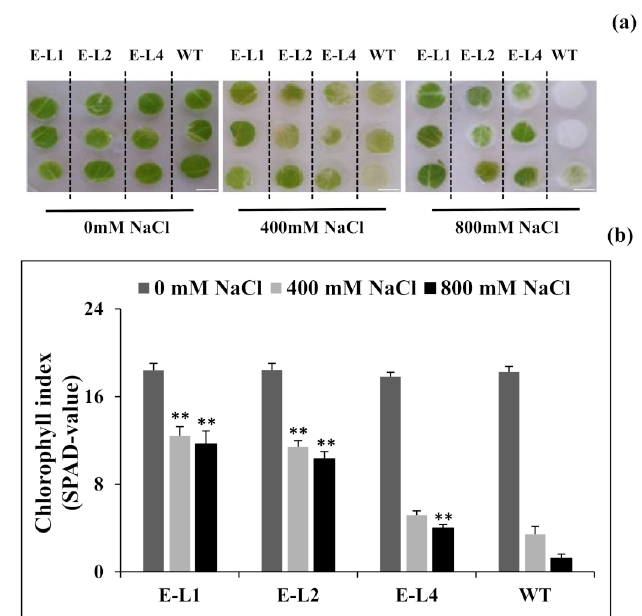
Figure 8. Representative phenotypes in transgenic tobacco lines and WT leaf tissues after salt treatments. ( a ) Leaf discs detached from transgenic plants overexpressing the TgERF1 and WT plants were floated on MS liquid medium supplied with 0, 400, and 800 mM NaCl for 3 days. Bar: 0.5 cm. ( b ) Chlorophyll index (SPAD-value) in leaf tissues after salt treatment. In each experiment, 15 leaf discs/line were used. Bars represent mean value ± SEM. Significant differences were determined by ANOVA followed by Dunnett’s test. ** Significant at p <